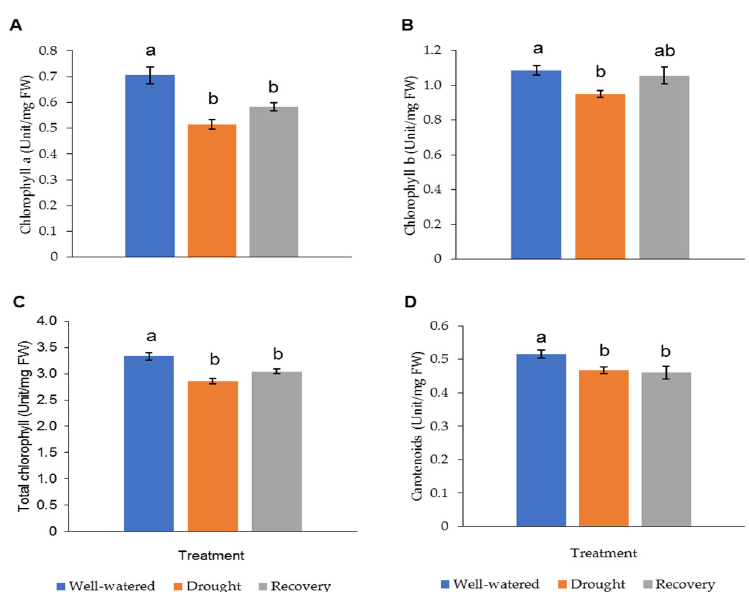
Figure 4. Pigment content of leaf samples for well-watered, drought-stressed, and recovered Panda- nus amaryllifolius . The concentrations of ( A ) chlorophyll a (U mg − 1 DW), ( B ) chlorophyll b (U mg − 1 DW), ( C ) total chlorophyll (U mg − 1 DW), and ( D ) carotenoids (U mg − 1 DW). Means labeled with alphabet were significantly different based on the ANOVA followed by post hoc when its p -value < 0.05.